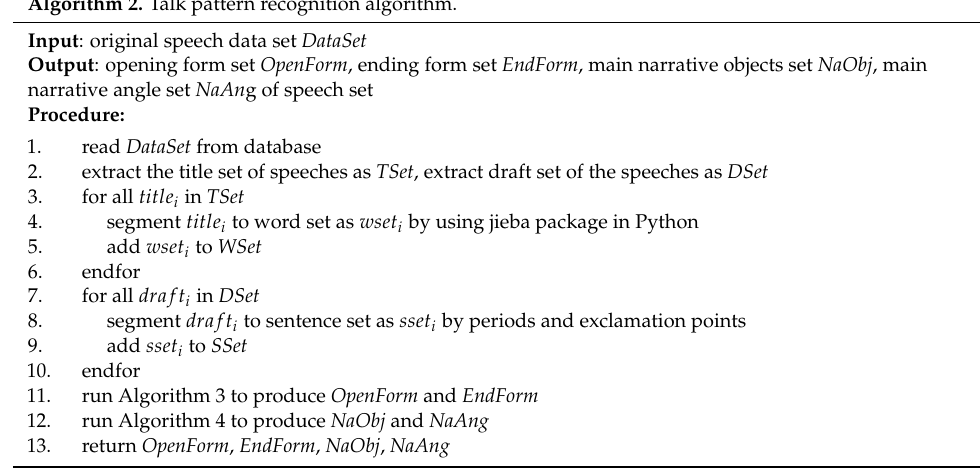
Algorithm 2. Talk pattern recognition